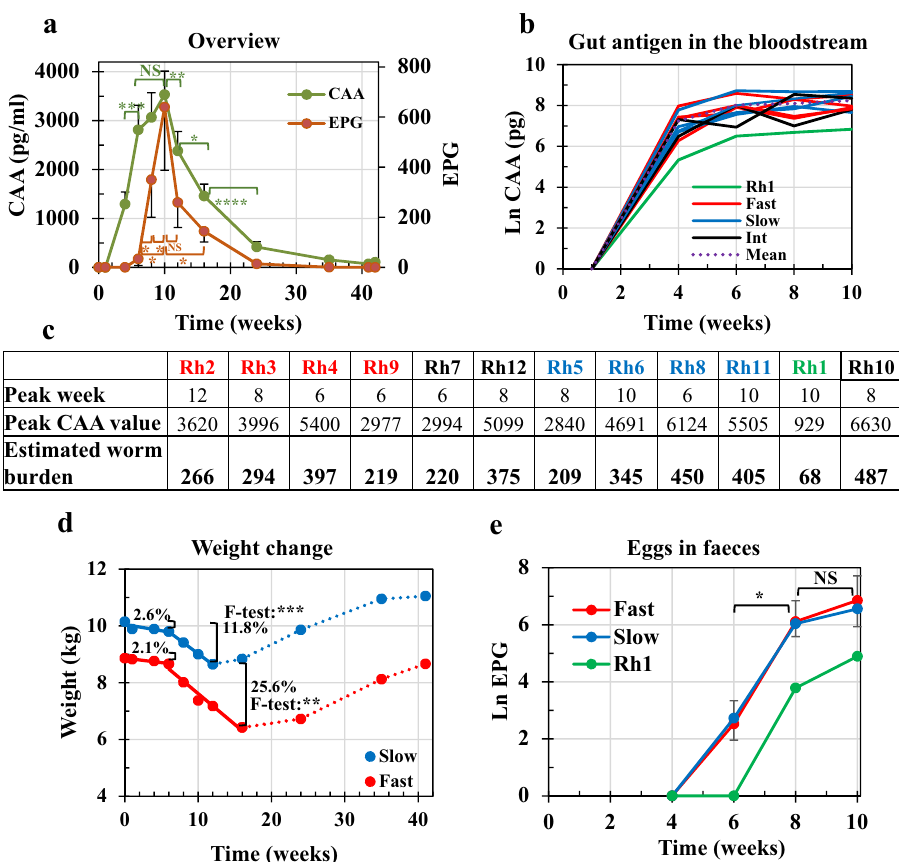
Fig. 2 Overview of the primary infection and analysis of the establishment phase. a The pro fi le of circulating anodic antigen (CAA) and faecal egg output (eggs per gram, EPG) over the primary time course. Values are means ± SE. Statistical comparisons made using one-sided Student ’ s t -test are indicated with brackets. For CAA values, P = 0.0009 (Wk6 versus Wk4), P = 0.0082 (Wk12 vs Wk10), P = 0.022 (Wk16 versus Wk12) and P < 0.0001 (Wk24 versus Wk16). For EPG values, P = 0.0203 (Wk8 versus Wk6), P = 0.0219 (Wk10 vs Wk8), P = 0.0109 (Wk10 versus Wk6) and P = 0.024 (Wk16 versus Wk10). Signi fi cance P < 0.05 *, <0.01 **, <0.001 ***, <0.0001 ****; n = 11 rhesus macaques, except Rh10. b The level of CAA in the bloodstream as an indicator of worm maturation in each animal over the establishment phase. The colours of plot lines denote strati fi cation into Fast (red), intermediate (black) and Slow (blue) responder groups, plus Rh1 (green) based on cure rate; dotted line ( …… ) indicates the mean of all animals. c The peak value attained by the CAA level in each animal, its week post-infection and the predicted adult worm burden, estimated from ref. 43 . Rh10, with the highest values, was withdrawn from the study. d Mean weight change of Fast and Slow groups over the primary time course. The signi fi cance of the linear regressions was determined using an F -test with values over Weeks 0 – 6 not signi fi cant; Slow, weeks 6 – 12, P = 0.00049 (***); Fast, weeks 6 – 16, P = 0.0029 (**); n = 4 macaques from the Slow and 4 from the Fast groups. The percentage weight loss over the respective periods is indicated by brackets. e The pattern of egg detection in the faeces over the establishment phase for Fast and Slow groups, plus Rh1. Statistical comparisons using one- sided Student ’ s t -test, as above. P = 0.0394 and 0.0291 (Wk8 versus Wk6) for Fast and Slow groups, respectively. P < 0.05 *. Values are means ± SE, n = 4 macaques from the Slow and 4 from the Fast groups. Source data are provided as a Source Data fi